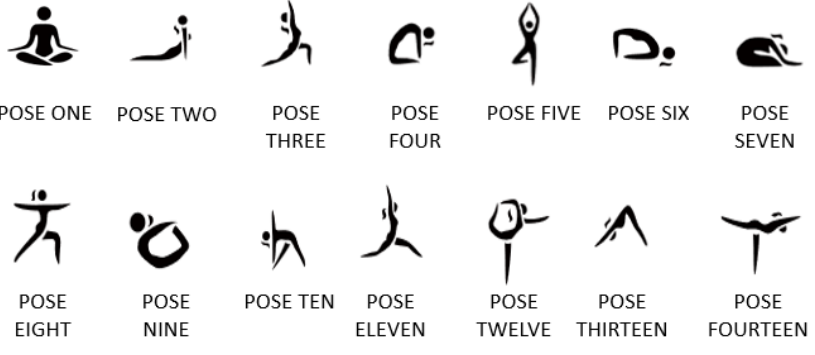
Figure 1. Yoga movements in WiPg.